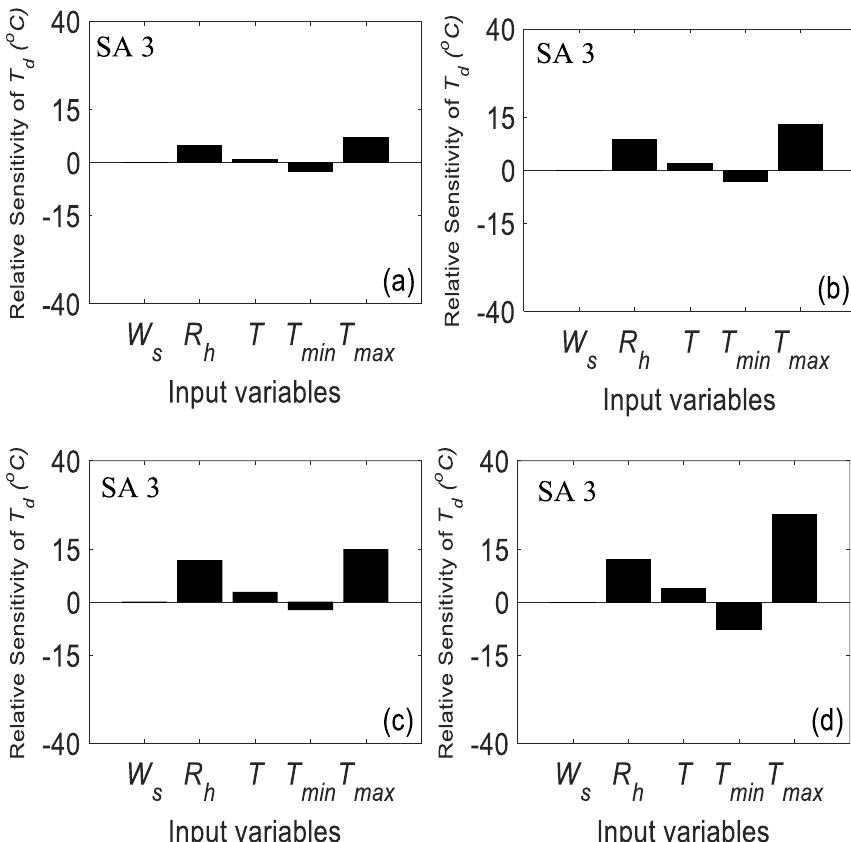
Fig. 15 Sensitivity analysis chart for configuration scenario